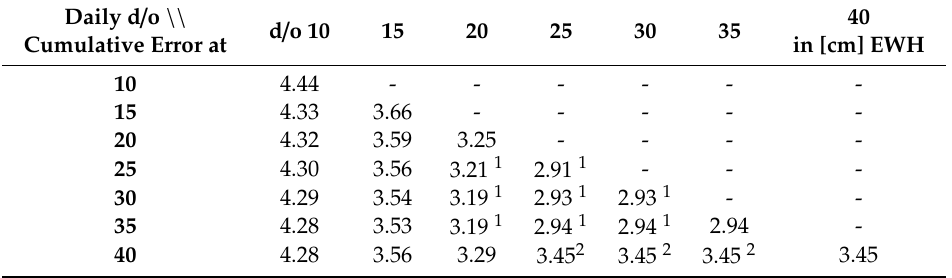
Table 6. Daily Cumulative error of di ff erent daily solutions from scenario 3pii,b including omission error (reference solution up to d / o 40) in cm EWH. Compare to Table 5. The best values are marked with “1”. The values marked with “2” implicate an over-parametrization, impacting the result